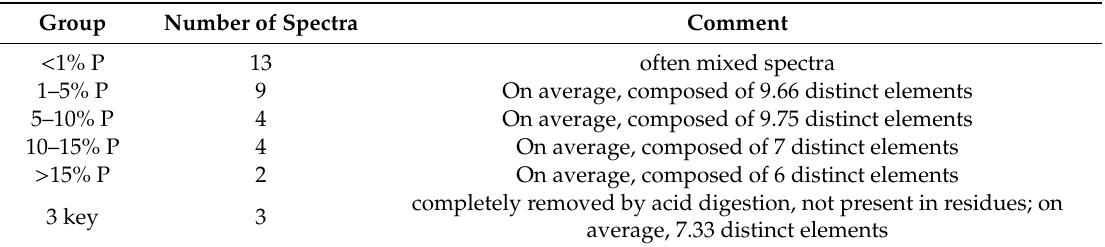
Table 1. Target component grouping—number of spectra and elemental complexity in each group. Group Number of Spectra